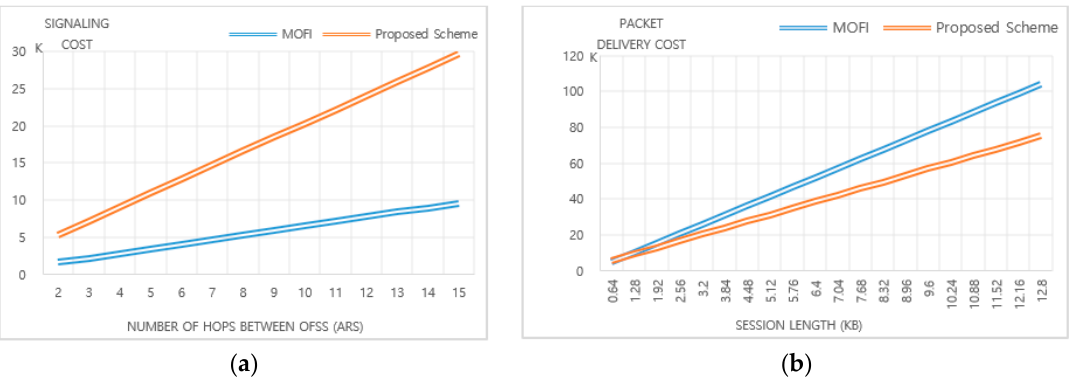
Figure 5. Comparison between Mobile Oriented Future Internet (MOFI) vs. proposed scheme: ( a ) signaling cost comparison; ( b ) packet forwarding cost comparison.